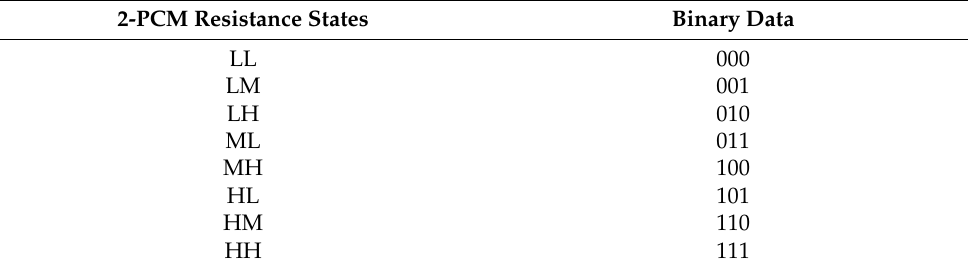
Table 1. The relationship of data states and PCM resistance states.